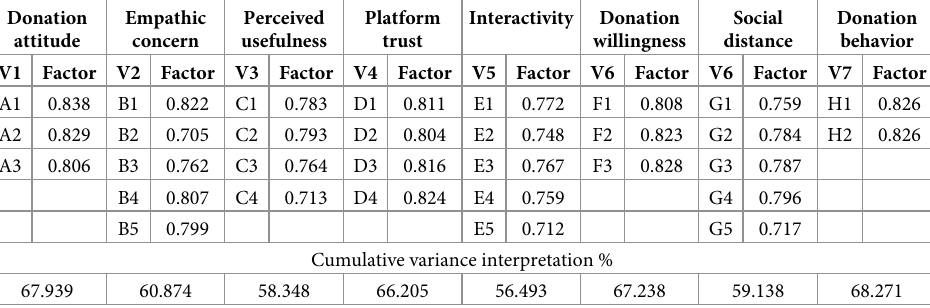
Table 4. Rotated factor analysis(Factor